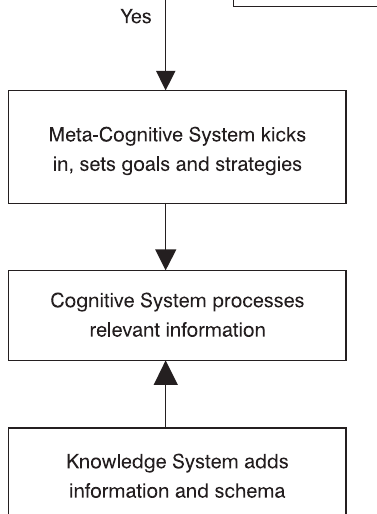
Figure 1. The four systems of learning and their